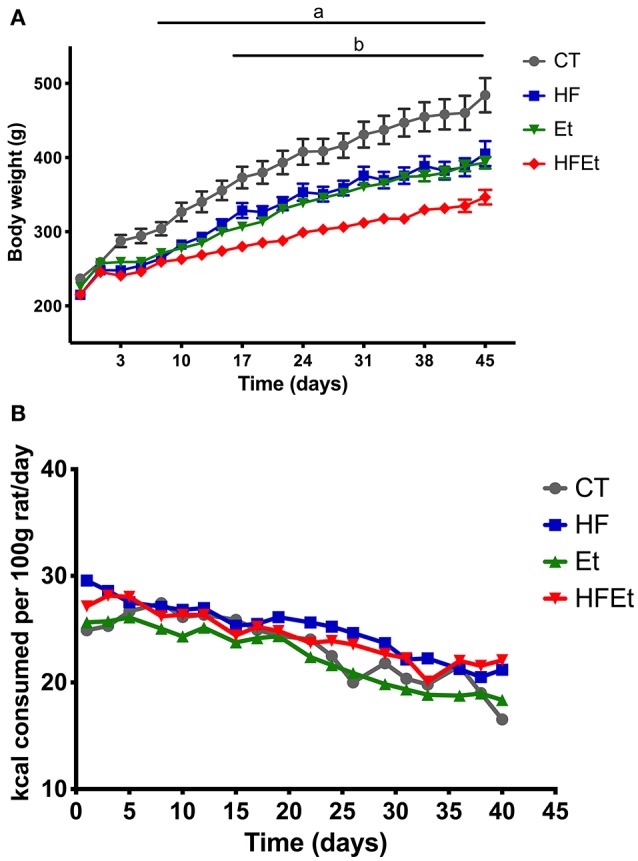
Body weight (A) and food intake (B) of rats fed with control diet (CT), high fructose diet (HF), ethanol (Et), or a mix (HFEt) during 6 weeks. Values are mean ± SEM (n = 8/diet for each time point). a: Statistical difference between CT vs. HF, Et, and HFEt from the 10th day until the end of the protocol. b: Statistical difference between HFEt vs. HF and Et from the 17th day until the end of the protocol.